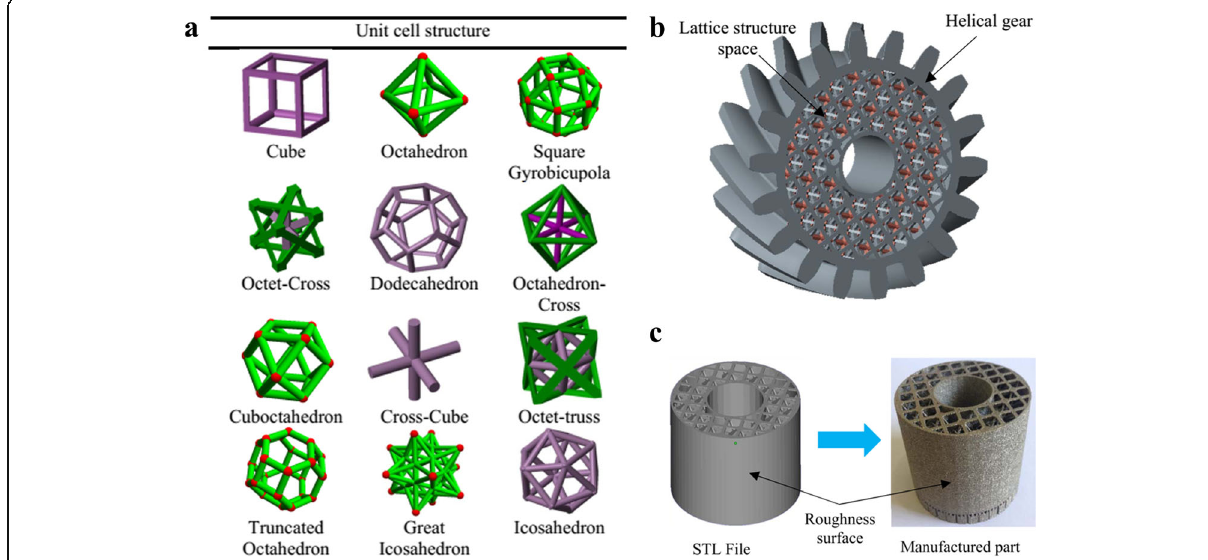
Fig. 19 Lattice structure design based on the unit libraries: a Unit cells. b Designed products with lattice structures. c Manufacturing result by 3D printing